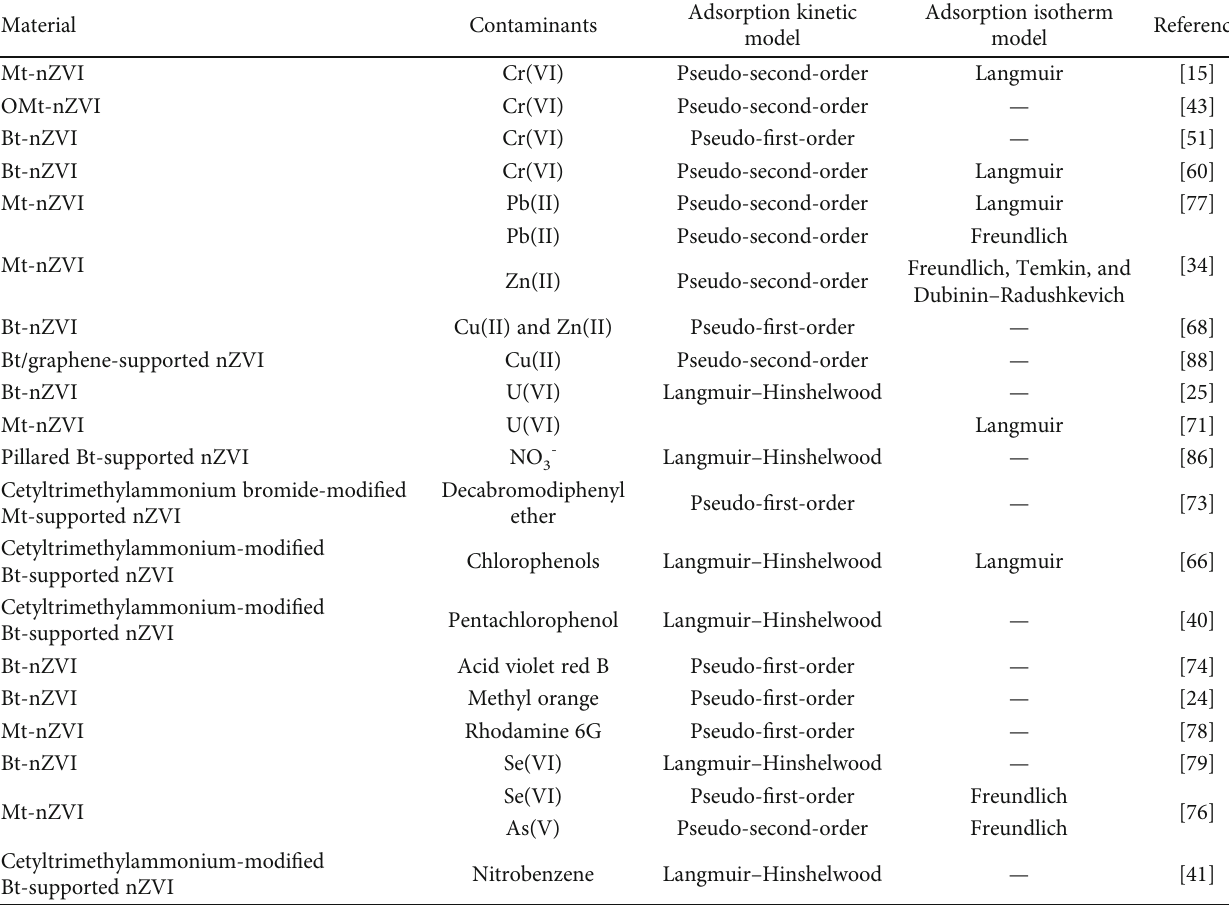
Table 4: Fitting results for the adsorption kinetic and isotherm models of contaminant removal by